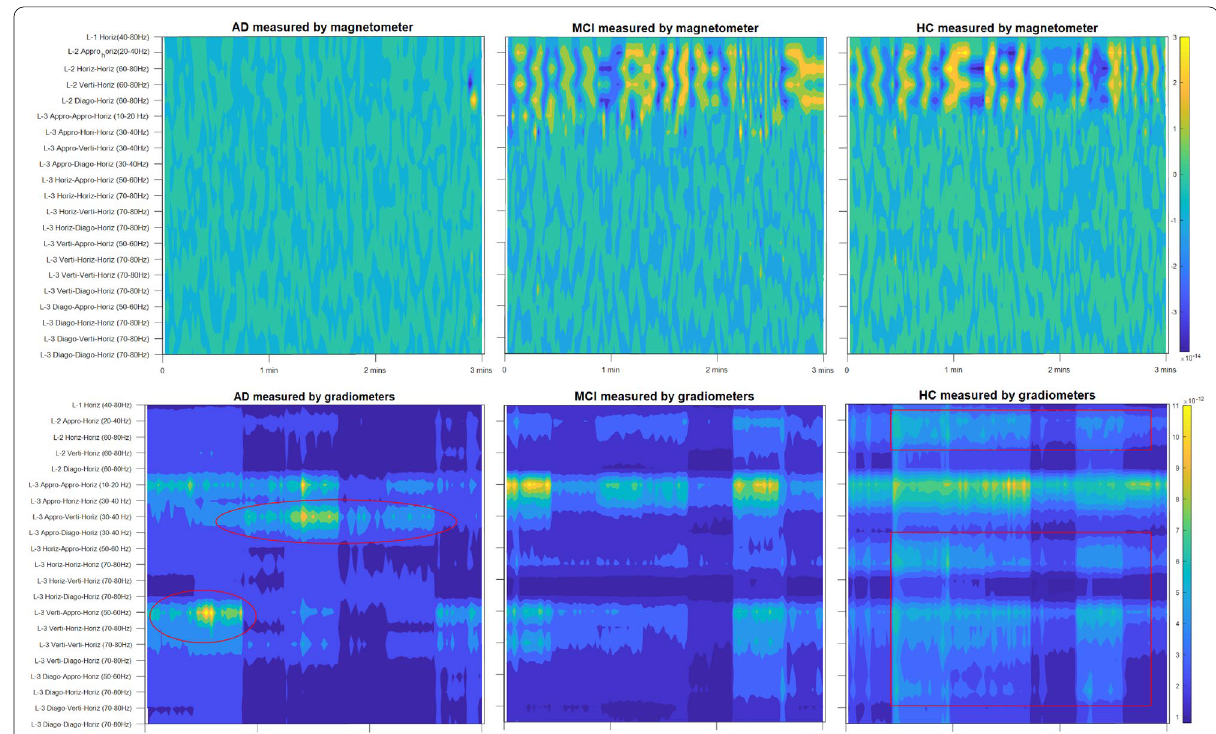
Fig. 4 Feature heat maps for two modalities, magnetometer (first row) and gradiometer (second row), using data from all the participants of three classes: AD, MCI and HC. L‑1, L‑2 and L‑3 indicate the level of decomposition. The horizontal axis indicates the recording